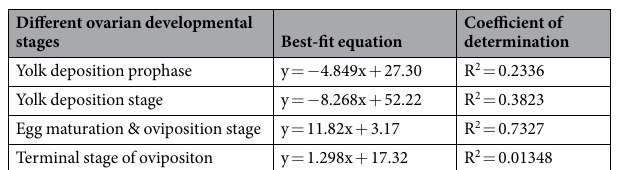
Table 1. Regression analysis of daily fecundity in variable proportion of different ovarian developmental stages of OFM